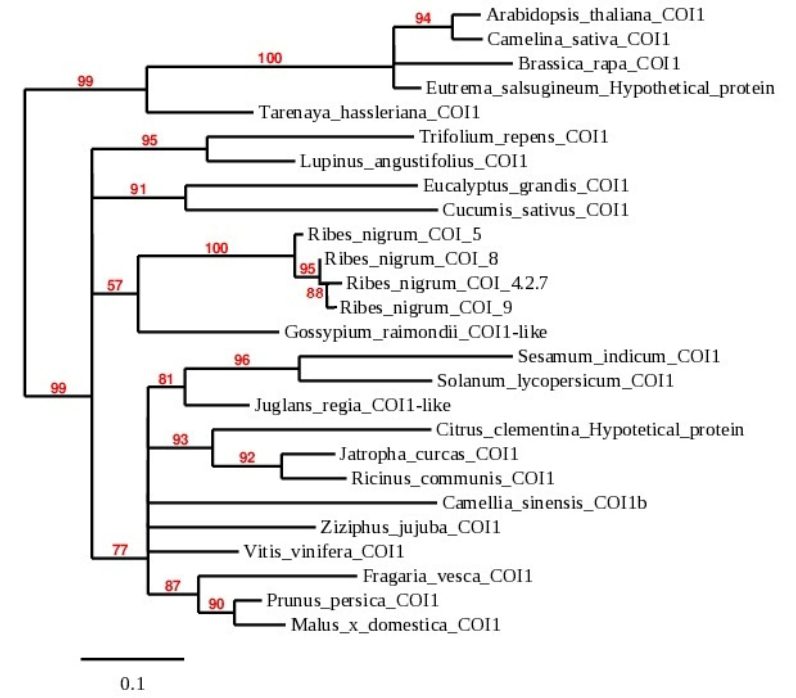
Figure 6. Phylogenetic dendrogram of COI1 genes constructed from nucleotide sequences of 22 plant species. Accession numbers of newly obtained COI1 sequences in R. nigrum in our research are OK625547—OK625550 (Table S5); accession numbers of other plants in Figure 6 are available in Table S2.